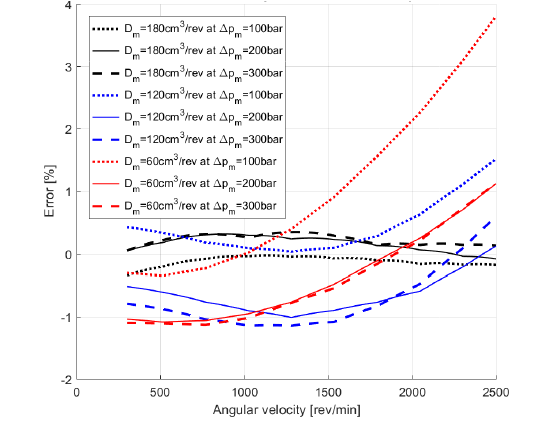
Figure 10: Comparison of two different motors with the same friction model structure. ”Cost” is data from the optimization algorithm and is representing the summarized squared error between the supplier data and the model. The data is then normalized from 0 to